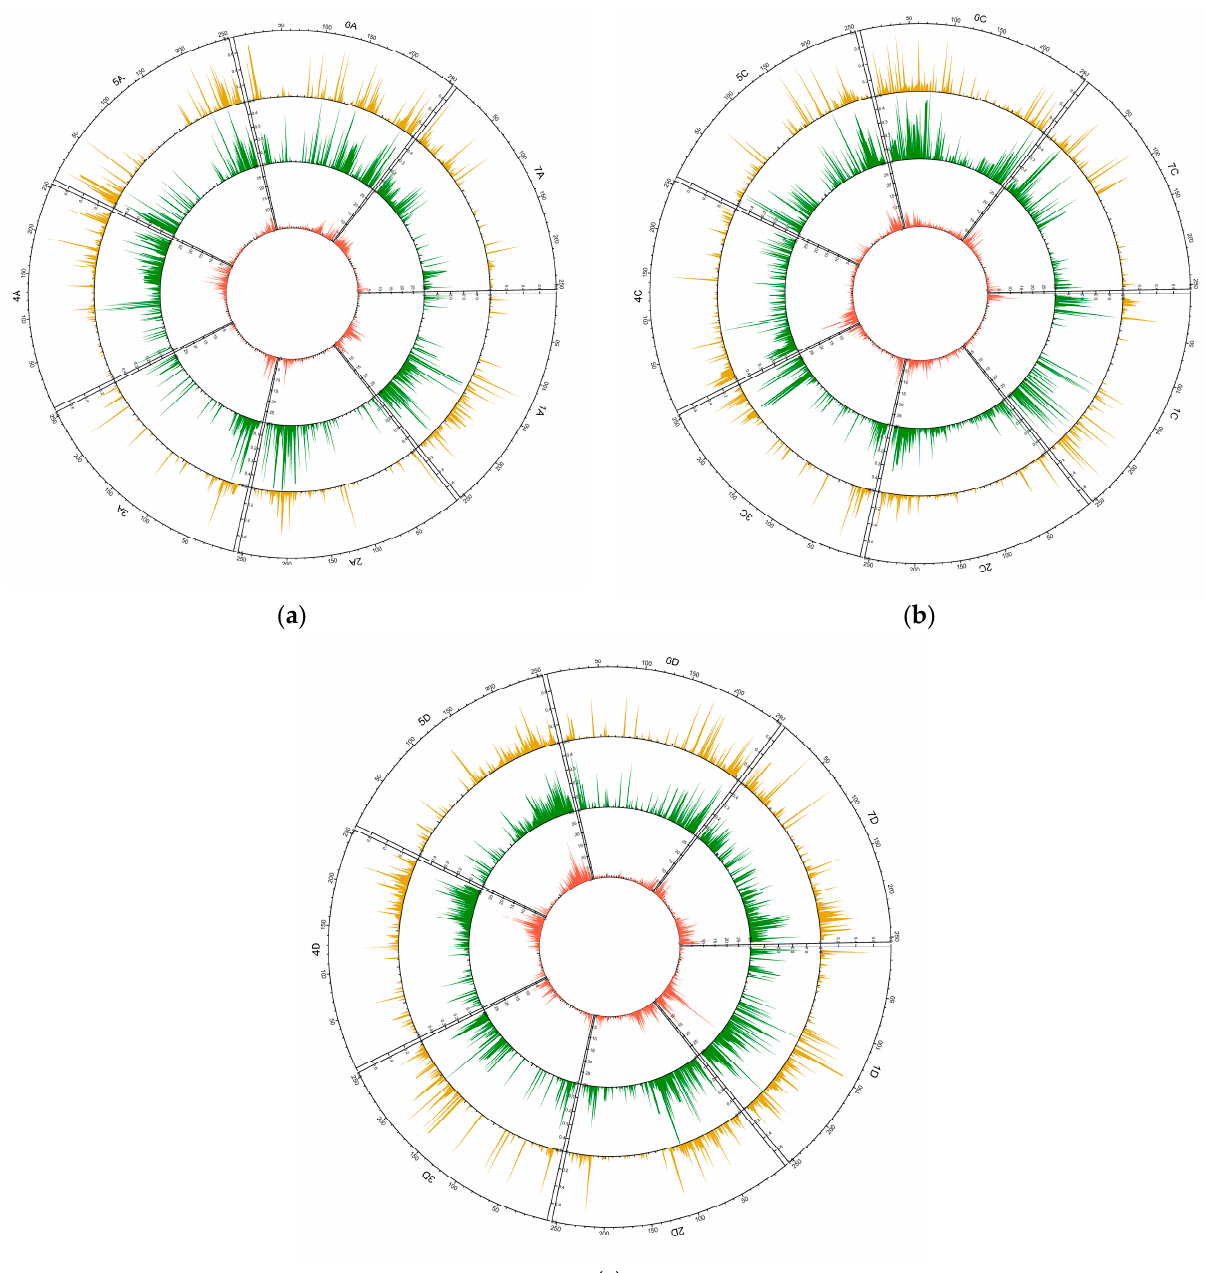
Figure 1. Circular overview of 21 chromosomes of A, C, and D oat reference genome OT3098 [23] for 487 A. sativa genotypes based on DArTseq data. ( a ) DArTseq loci distribution; ( b ) average polymorphism information content (PIC) distribution; and ( c ) average observed heterozygosity (Ho)